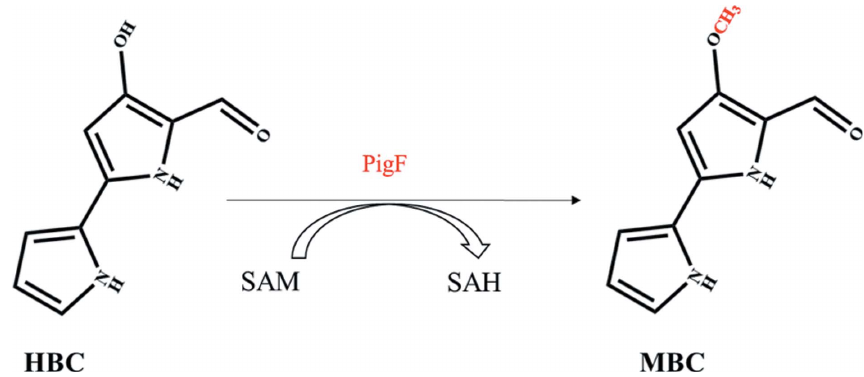
Figure 2 The last step in the MBC biosynthesis pathway: PigF transfers a methyl group to HBC to form the final product